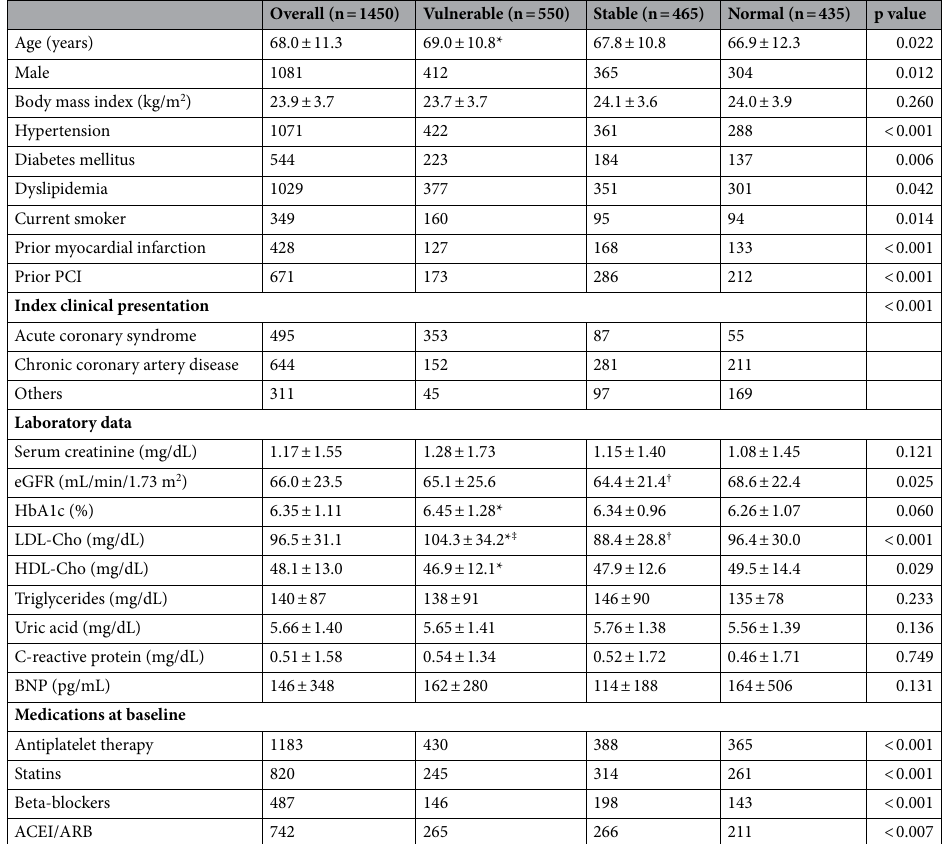
Table 1. Clinical characteristics of the patients in dataset 3 according to the classification by the AI algorithm. The values are presented as the means ± SD. *p < 0.05 vulnerable vs. normal. † p < 0.05 stable vs. normal. ‡ p < 0.05 vulnerable vs. stable. PCI percutaneous coronary intervention, eGFR estimated glomerular filtration rate, HbA1c hemoglobin A1c, LDL-Cho low-density lipoprotein cholesterol, HDL-Cho high-density lipoprotein-cholesterol, BNP brain natriuretic peptide, ACEI angiotensin-converting enzyme inhibitor, ARB angiotensin II receptor blocker.